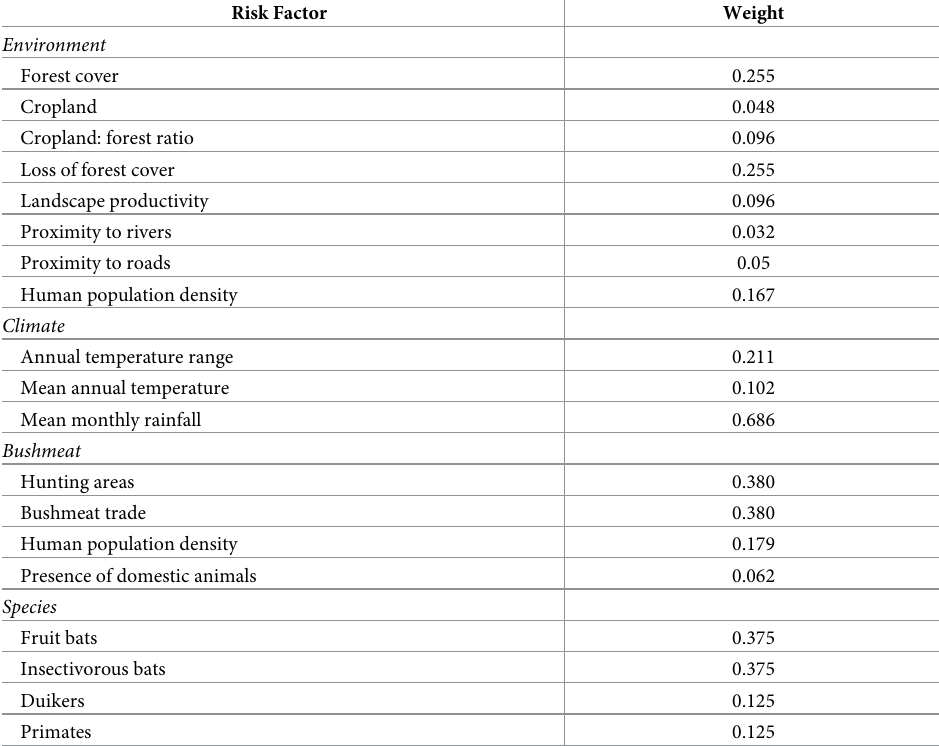
Table 2. Weights for risk factors resulting from the